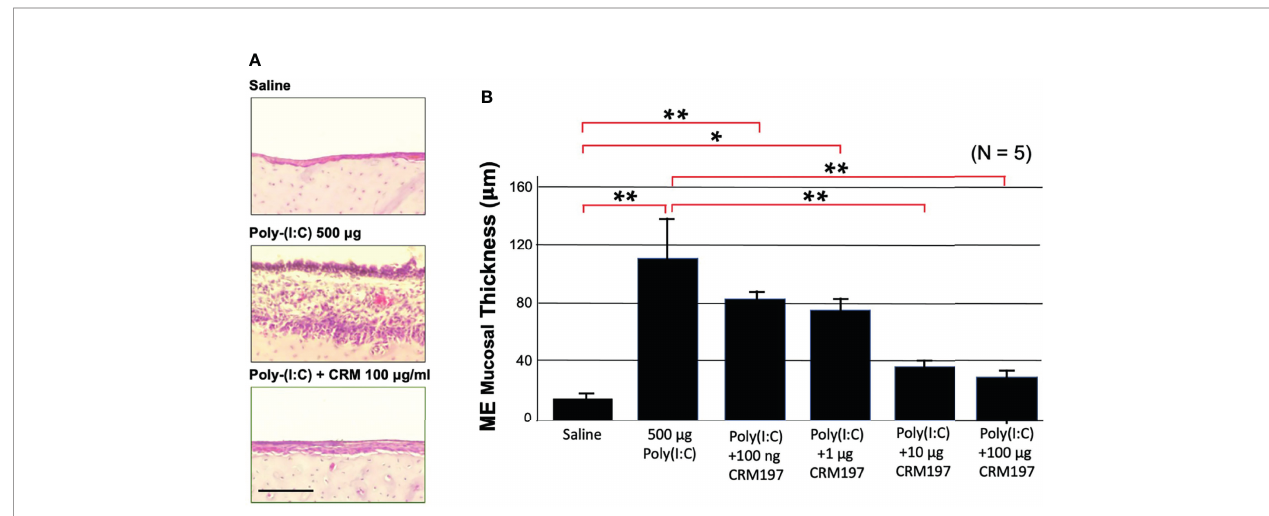
FIGURE 4 | An HB-EGF inhibitor decreases mucosal thickness during OM. Poly(I:C)-induced hyperplasia of rat ME mucosa was inhibited by co-administration of CRM197. (A) Representative microphotographs are shown on day 2. Scale bar = 100 m m. (B) Mean thickness of saline ME mucosa versus 500 ug of Poly(I:C), without or with various levels of CRM197 on day 2. N refers to number of MEs. *p < 0.05; **p <